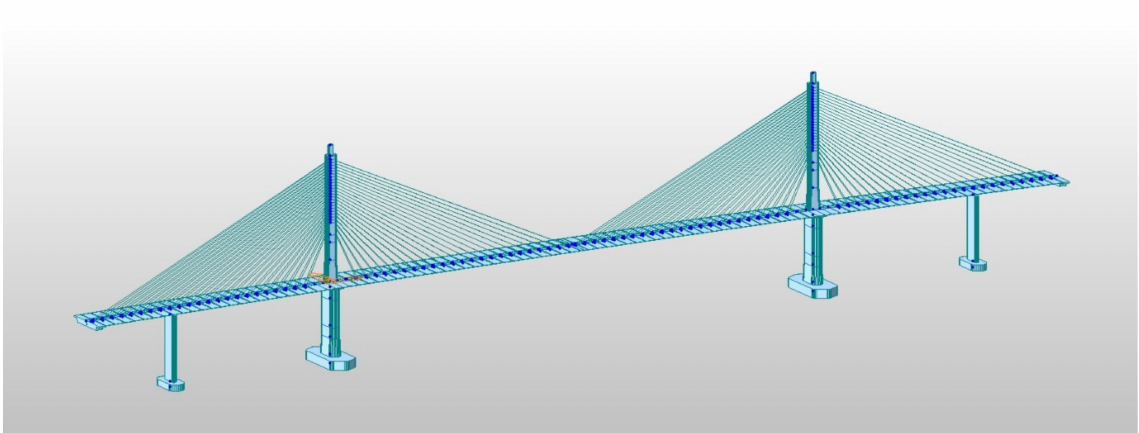
Figure 7. Finite element model of the cable-stayed bridge.